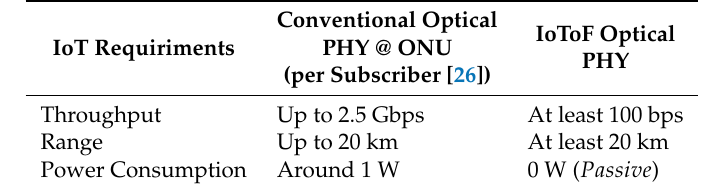
Table 1. The internet of things (IoT) requirements and conventional optical physical connectivity (PHY) at Optical network unit (ONU) and IoT over fiber (IoToF) optical PHY. Conventional Optical IoToF Optical PHY @ ONU IoT Requiriments (per Subscriber [26])